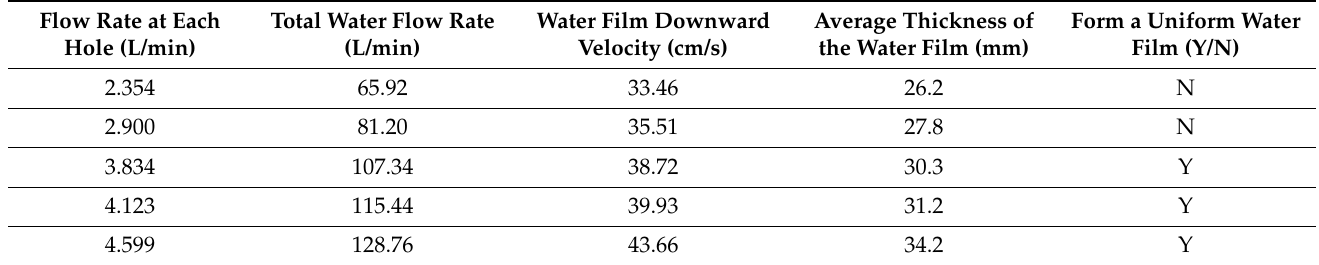
Figure 3. Schematic of the water film system. Table 2. The relationship between the total water flow rate and uniformity of the water film before the fire test.